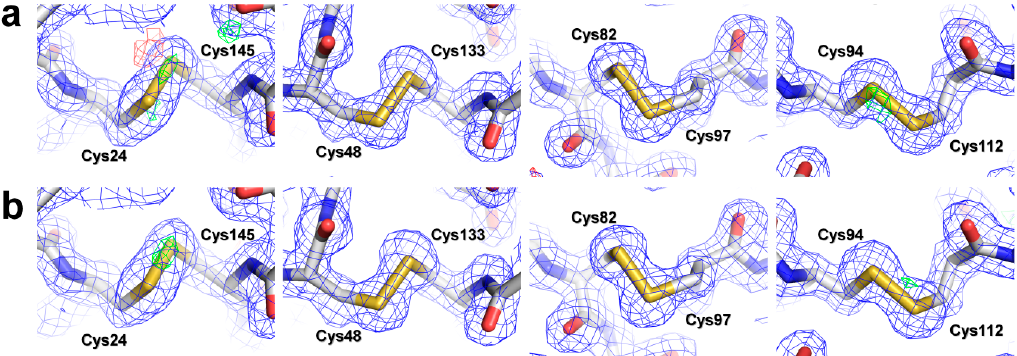
Figure 5. Both 2mFo-DFc (blue, 1.2 σ ) and mFo-DFc (green, 3.0 σ and red, − 3.0 σ ) electron density maps of disulfide bonds of lysozyme by ( a ) 100 ms X-ray exposure with 0.011° oscillation, and ( b ) 500 ms X-ray exposure with 0.222° oscillation.